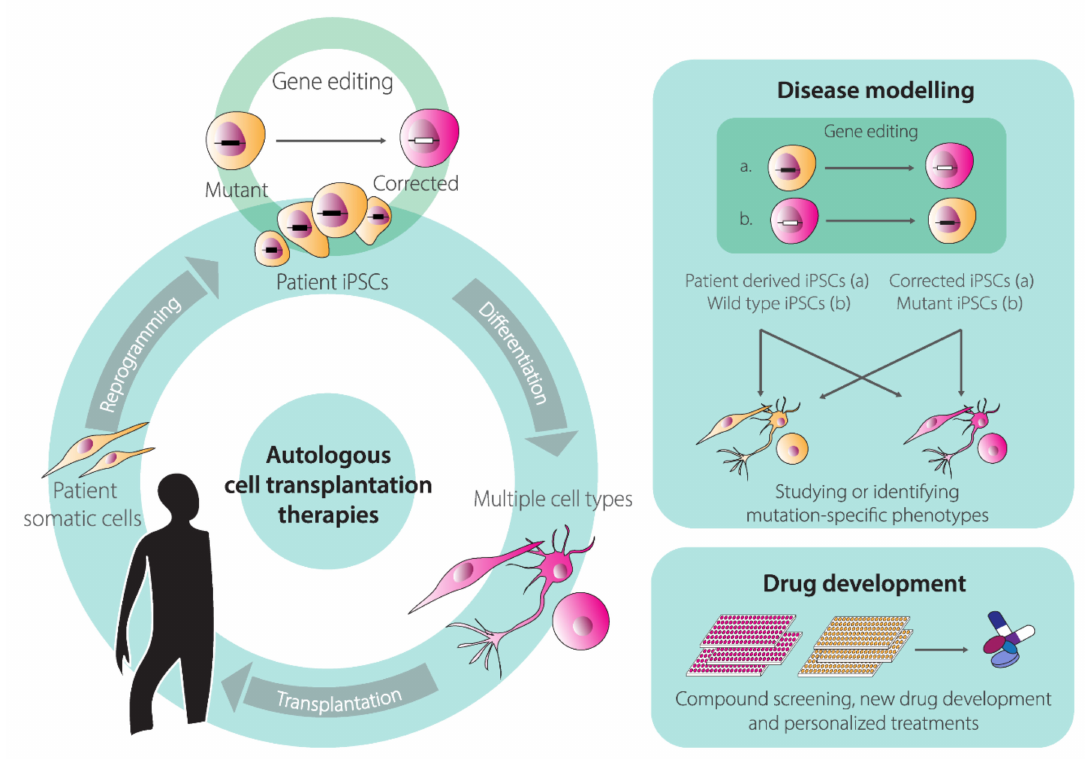
Figure 4. Illustration of human induced pluripotent stem cell (hiPSC)-based research and development activities enabled by genome editing technologies. Ex vivo reprogramming of patient-derived somatic cells into hiPSCs followed by their genetic correction, expansion, and directed di ff erentiation into specialized cells types opens the perspective for the development of innovative autologous cell therapies. Generation of hiPSC lines sharing the same genetic background and di ff ering from each other at predefined genetic loci can be accomplished via either ( a ) targeted correction of specific mutations in patient-derived hiPSCs or ( b ) targeted installation of specific mutations in wild-type, healthy donor-derived, hiPSCs. The resulting pairs of isogenic hiPSC lines form tractable experimental systems for the controlled and robust establishment of genotype-phenotype associations during disease modeling and for high-throughput screens aiming at assessing drug toxicities and / or identifying new drug